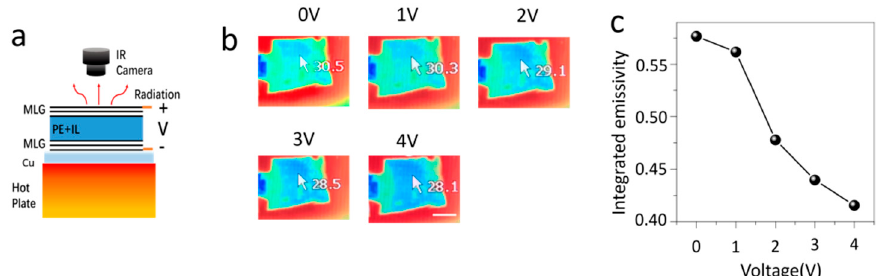
Figure 2. Thermal imaging of the ionic liquid intercalated multilayer graphene device. ( a ) Schematic of the thermal imaging process. In this process, the device is put on a polished copper plate and then on a hot plate. ( b ) The thermal images of the multilayer graphene device under different intercalation voltage bias. The scale bar in (b) is 1 cm. ( c ) The change of the integrated emissivity with intercalation voltage bias.